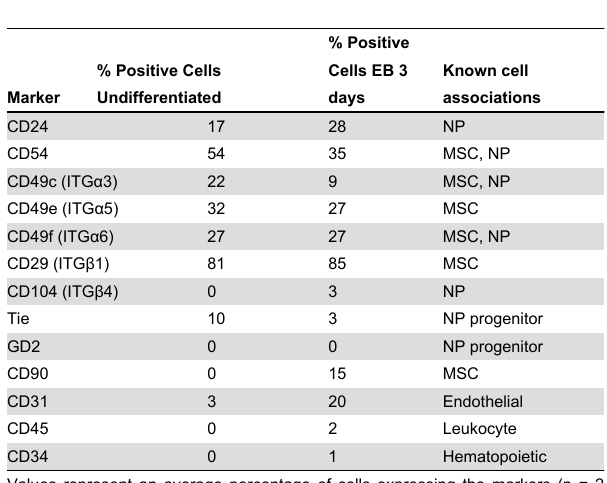
Table 3. NP and MSC associated marker expression in mouse iPSCs determined via flow cytometry